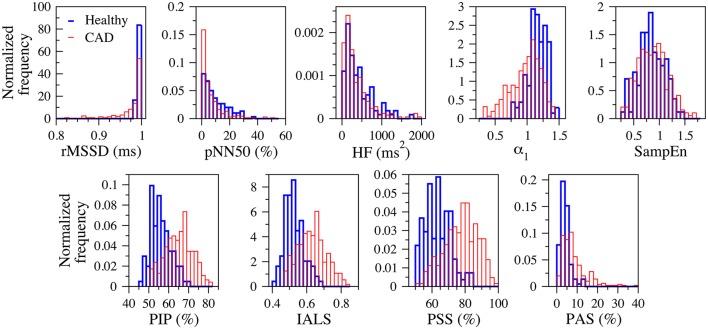
Normalized histograms of the traditional heart rate variability (rMSSD, pNN50, and HF), nonlinear (α1 and SampEn) and fragmentation (PIP, IALS, PPS, and PAS) indices for the groups of healthy subjects (blue) and patients with coronary artery disease (red), for the 24-h period. rMSSD, root mean square of the successive differences; pNN50, percentage of differences between successive NN intervals above 50 ms; HF, high frequency spectral power; α1, detrended fluctuation analysis short-term exponent; SampEn, sample entropy; PIP, percentage of inflection points; IALS, inverse of the average length of the acceleration/deceleration segments; PPS, percentage of NN intervals in short segments; PAS, percentage of NN intervals in alternation segments.